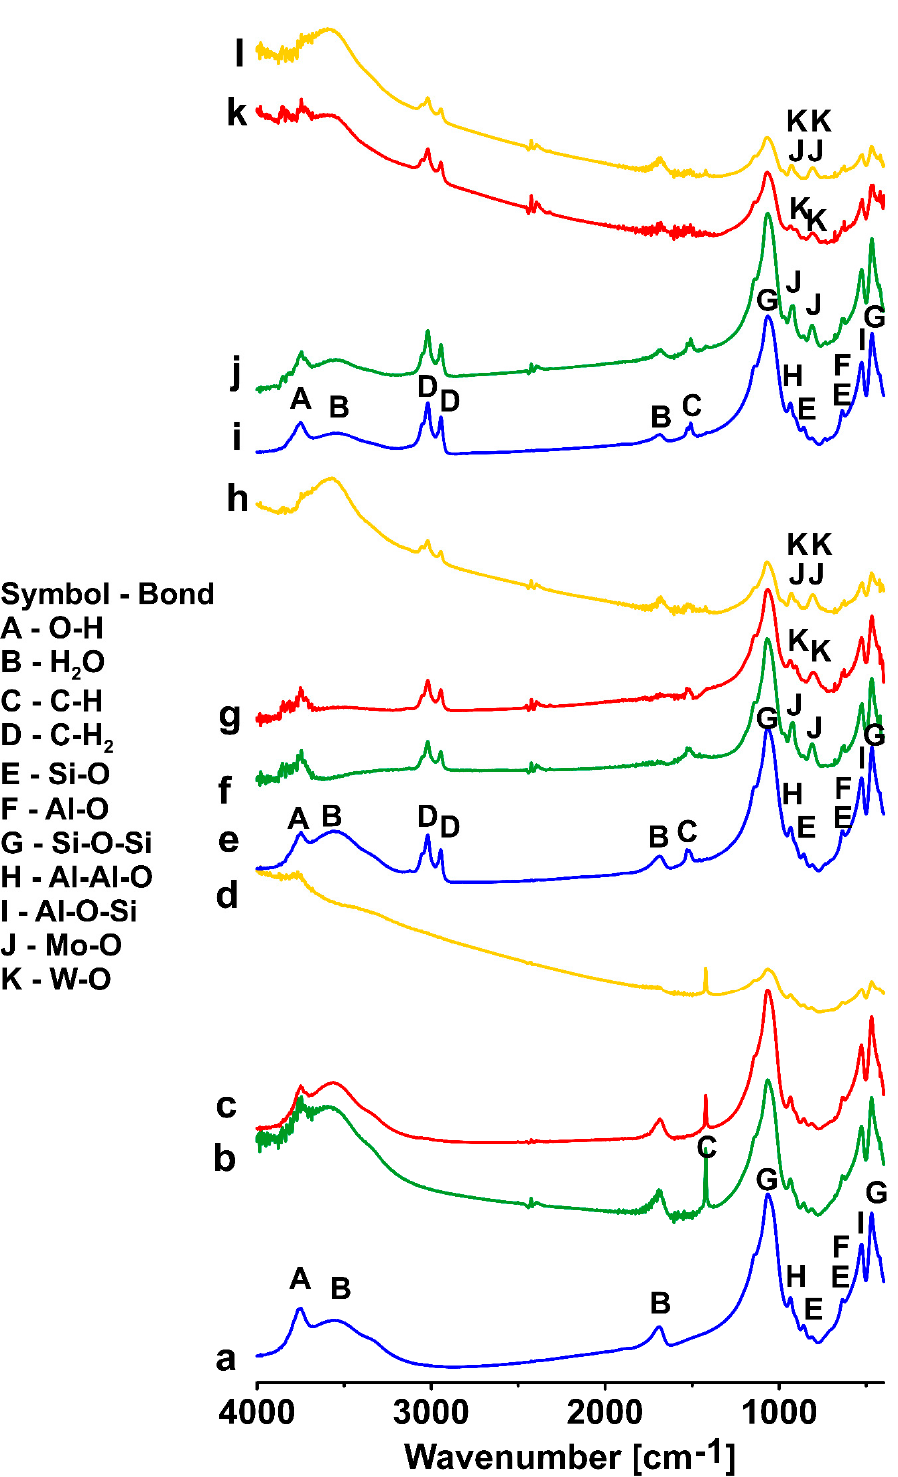
Figure 2. FTIR spectra of samples: ( a ) Na-M, ( b ) Na-M-Mo, ( c ) Na-M-W, ( d ) Na-M-MoW, ( e ) DDTMA-M, ( f ) DDTMA-M-Mo, ( g ) DDTMA-M-W, ( h ) DDTMA-M-MoW, ( i ) DDDDMA-M, ( j ) DDDDMA-M-Mo, ( k ) DDDDMA-M-W, ( l ) DDDDMA-M-MoW.